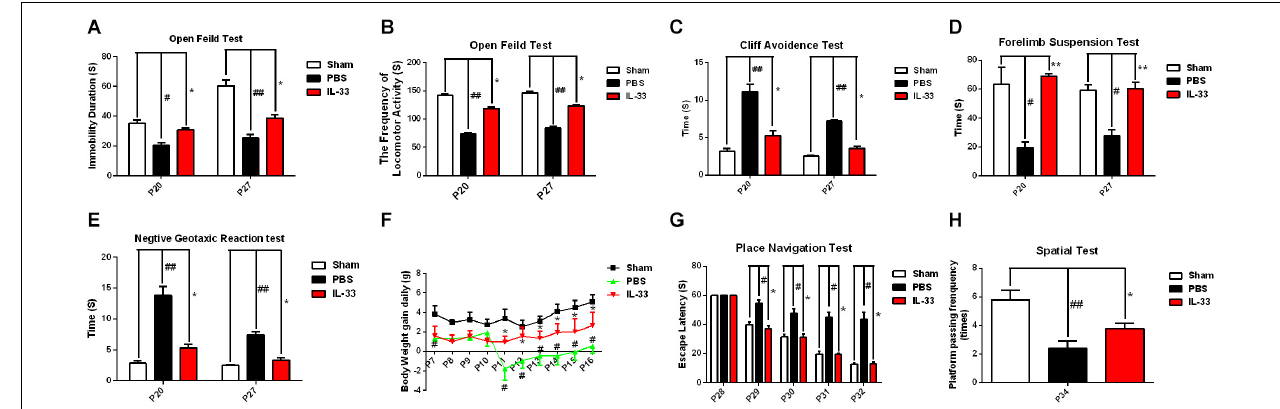
FIGURE 3 | IL-33 alleviated neurologic behavioral deficits, bodyweight loss, and performance in the Morris water maze (MWM) test after RNS. (A–E) The time of each group in the open field test, forelimb suspension test, negative geotactic test, and cliff avoidance test was recorded at P20 and P27, respectively. (F) IL-33 reversed RNS-induced the reduction in BWG during P7-P16. (G) In the MWM test, mean escape latency for each group was plotted during P28–P32. (H) The frequencies of crossing the platform were recorded at P34. The data were expressed as means ± SEM ( n = 6). ## P < 0.01 vs. Sham + PBS group, # P < 0.05 vs. Sham + PBS group. ** P < 0.01 vs. RNS + PBS group, * P < 0.05 vs. RNS + PBS group. Experiments are representative of three independent